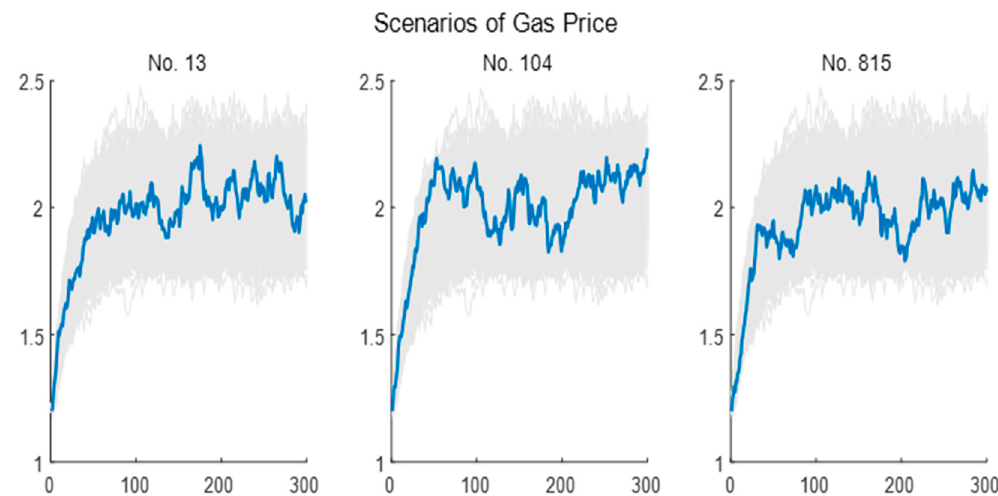
Figure 10. Mean value increase scenarios of gas prices.